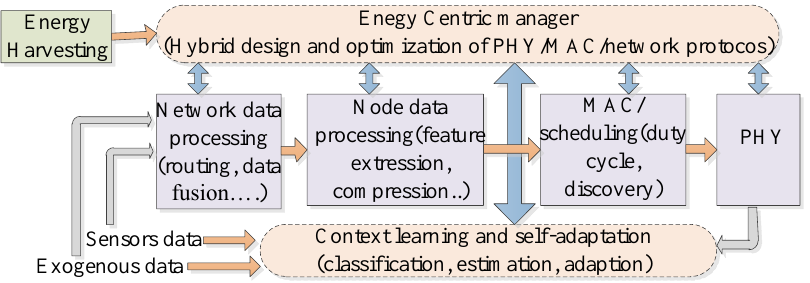
Figure 16. Communication stages of molecular communication using bacteria relay.